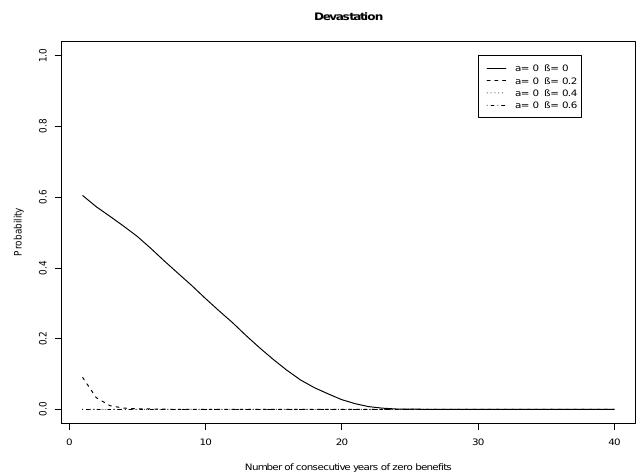
Figure 4. Devastation. The number of consecutive years in which there is no retirement benefit paid to a retiring generation, plotted against the probability. The AAF adjustment ( b ) is varied and the investment risk adjustment ( a ) is set equal to zero, and the target funding level ¯ F =